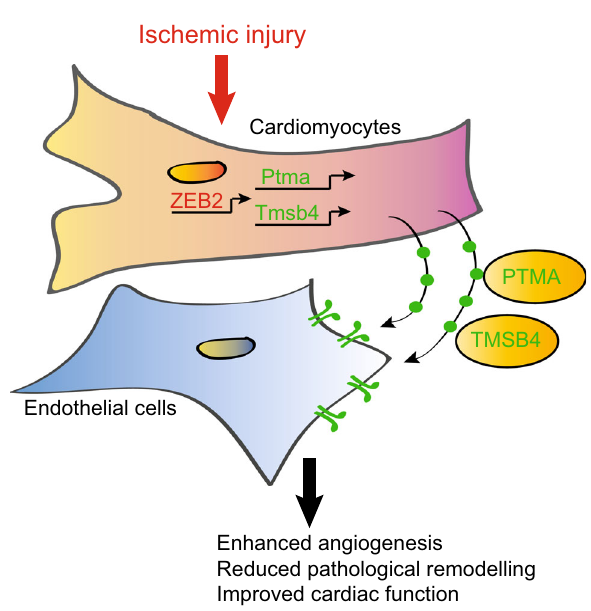
Fig. 9 ZEB2 expression in injured cardiomyocytes promotes angiogenic signaling. Model depicting the activation of ZEB2 in injured cardiomyocytes, resulting in transcriptional activation of Tmsb4 and Ptma followed by their secretion from cardiomyocytes subsequently enhancing the angiogenic